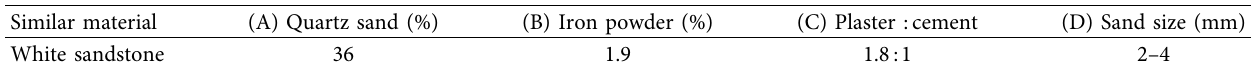
Table 11: Optimal ratio of similar materials obtained by multiple linear regression covered by the study.